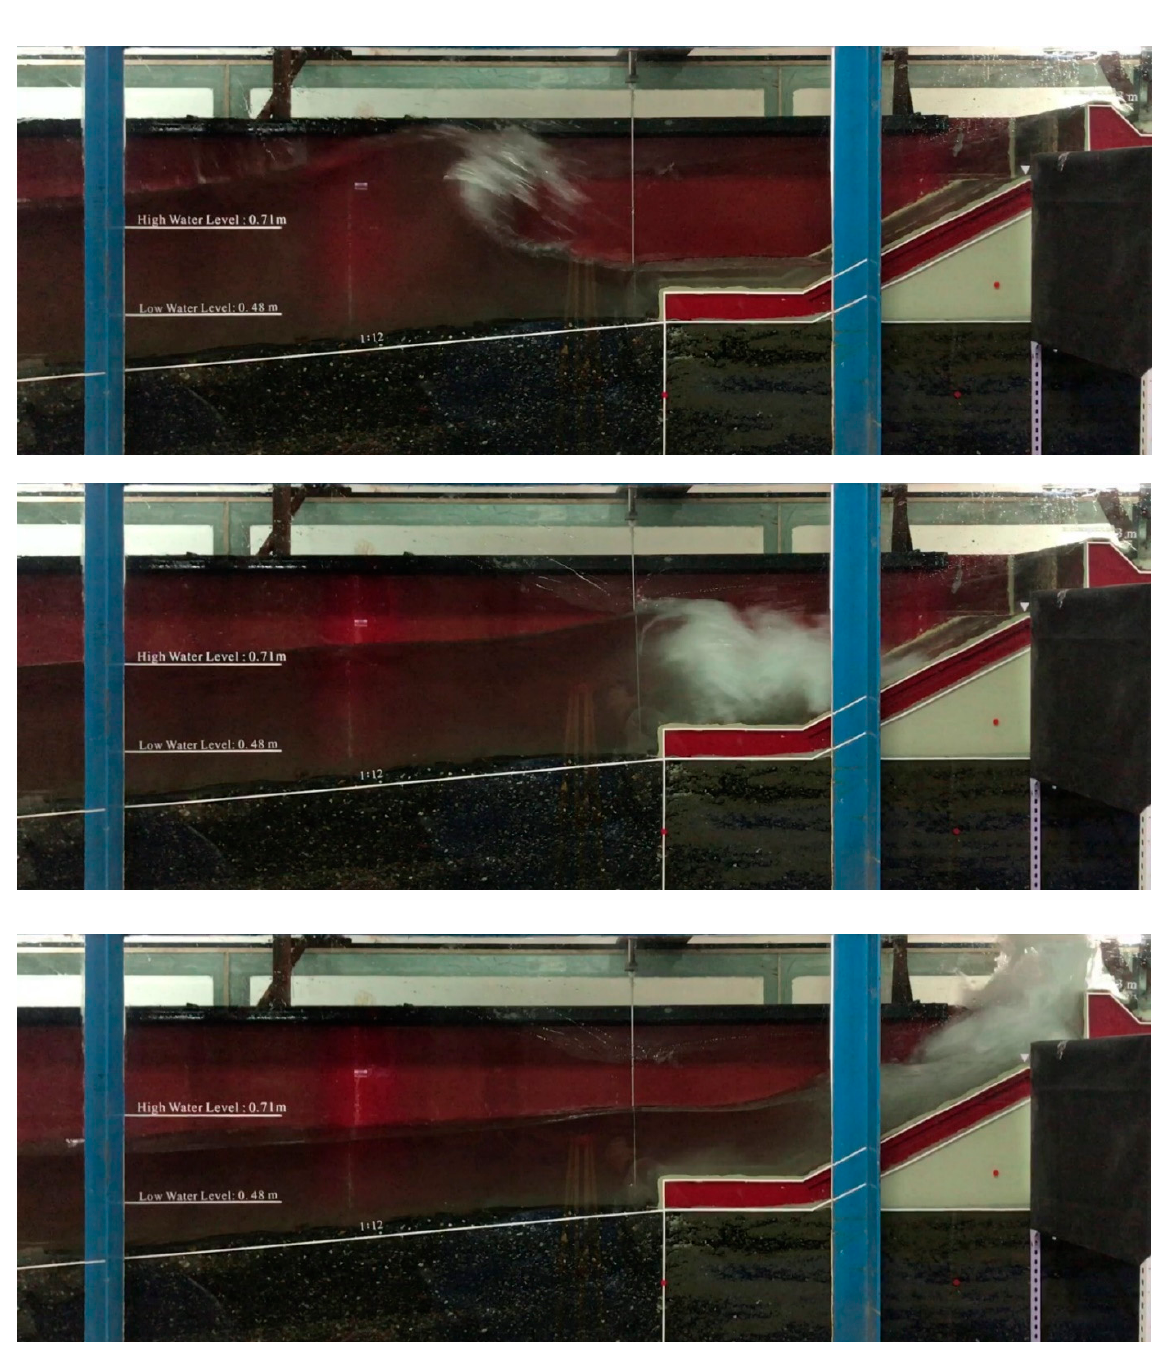
Figure 7. Revetment breakwater is being impacted by regular wave and water overtopping is occurring, observed in Test